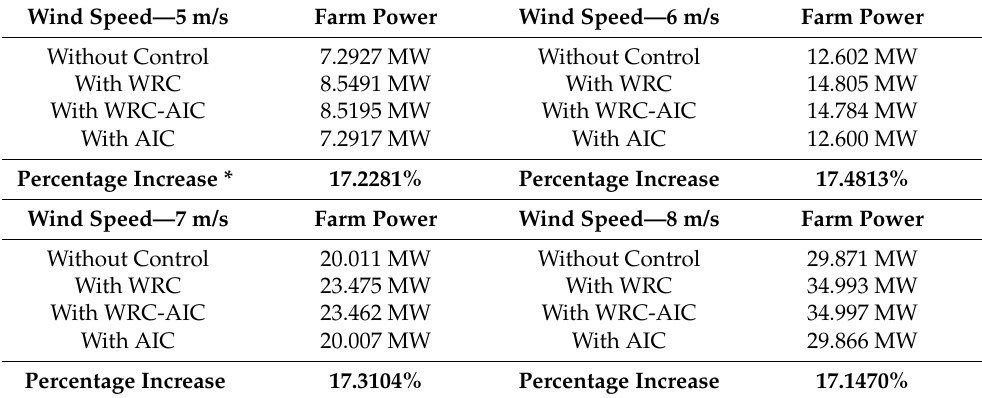
Table 2. Wind farm power at various wind speeds under various control methods.